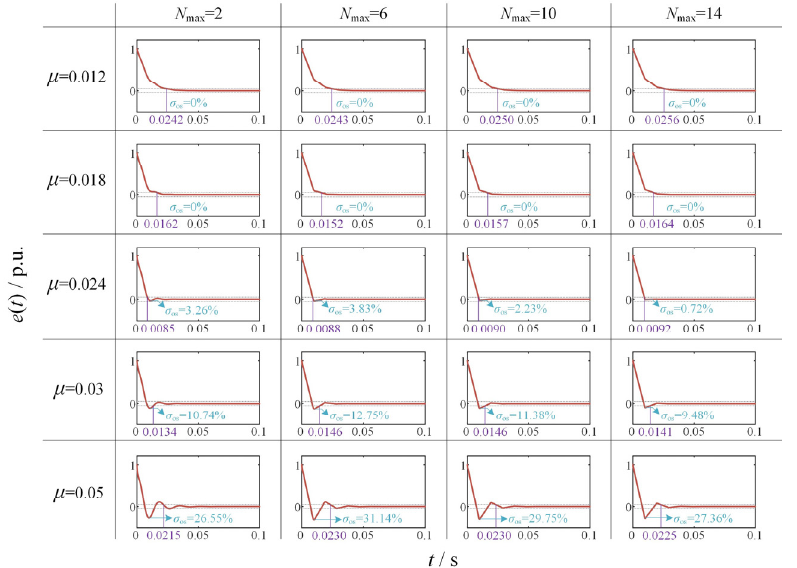
Figure 7. The relationships between the convergence curve of error e ( t ) and parameter µ under various N max .